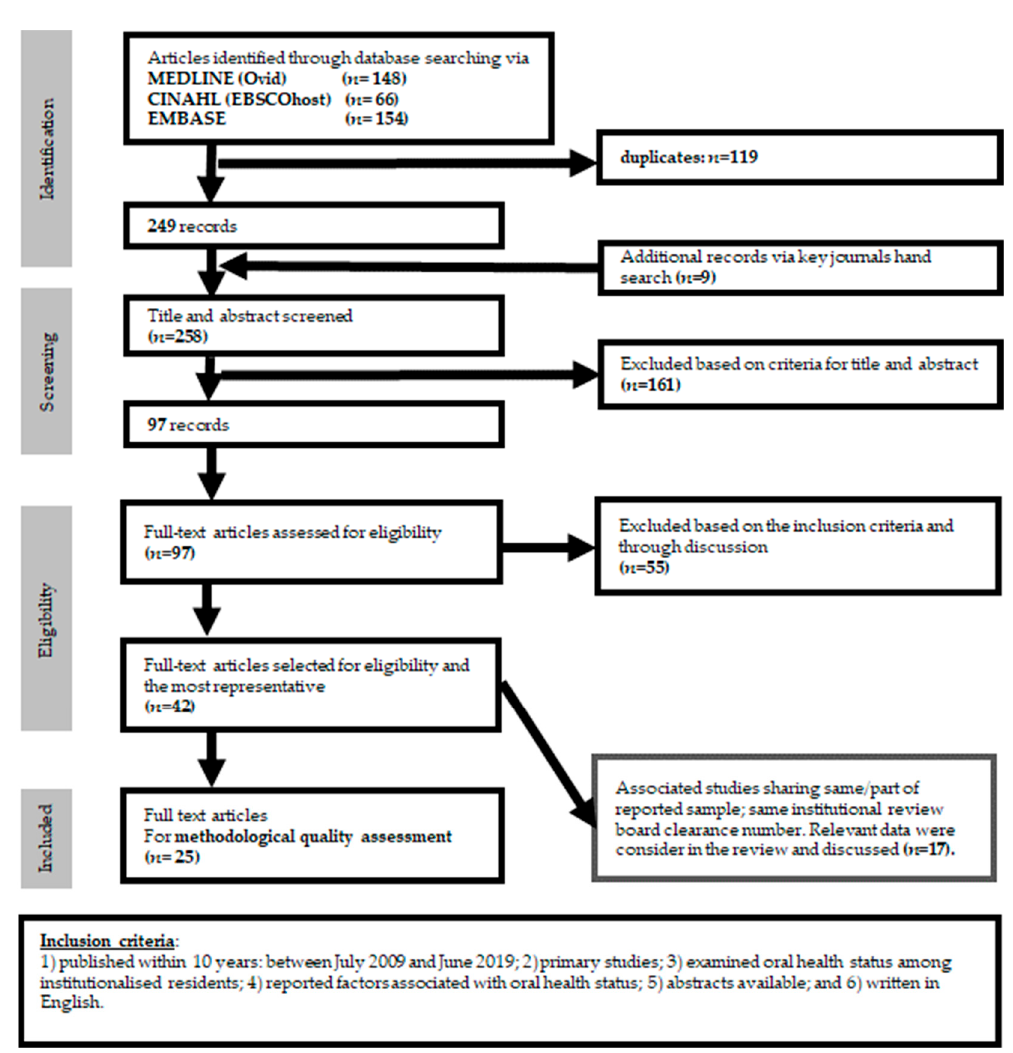
Figure 1. Preferred Reporting Items for Systematic Reviews and Meta-analysis (PRISMA) Flow Diagram: This figure shows the study selection process for included studies on oral health and its associated factors among institutionalized residents.